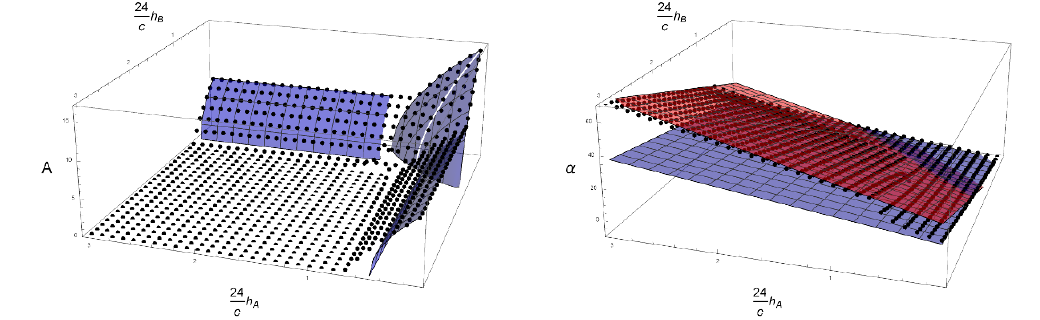
Figure 7 . The plot of the values of A (left) and α (right) for various values of h A and h B . The ranges are 0 < h A , h B < c . The black dots are the numerical values of A and α . The blue 8 surfaces are analytical predictions from the HHLL approximation. The red surface describes (3.26). We set c = 100 .